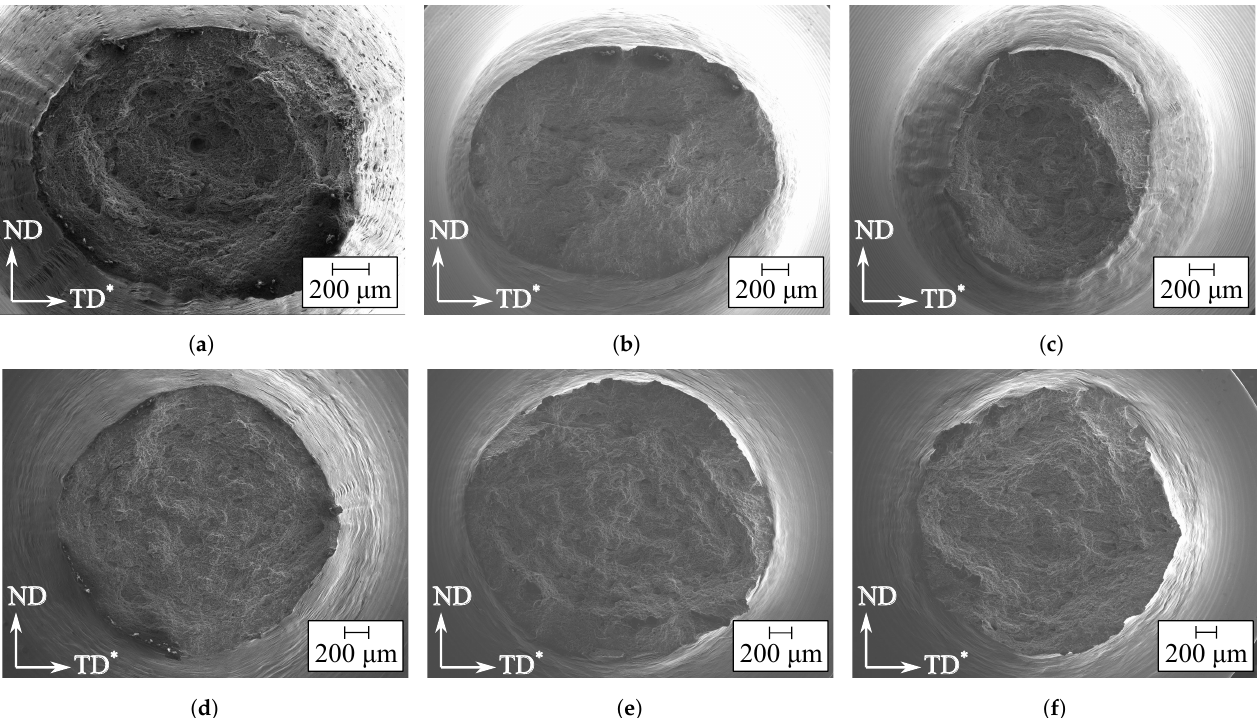
Figure 12. Fracture surfaces of representative tension tests for alloy AA6061. ( a ) Smooth, 0 ◦ , ( b ) Smooth, 45 ◦ , ( c ) Smooth, 90 ◦ , ( d ) R0.8, 0 ◦ , ( e ) R0.8, 45 ◦ , ( f ) R0.8, 90 ◦